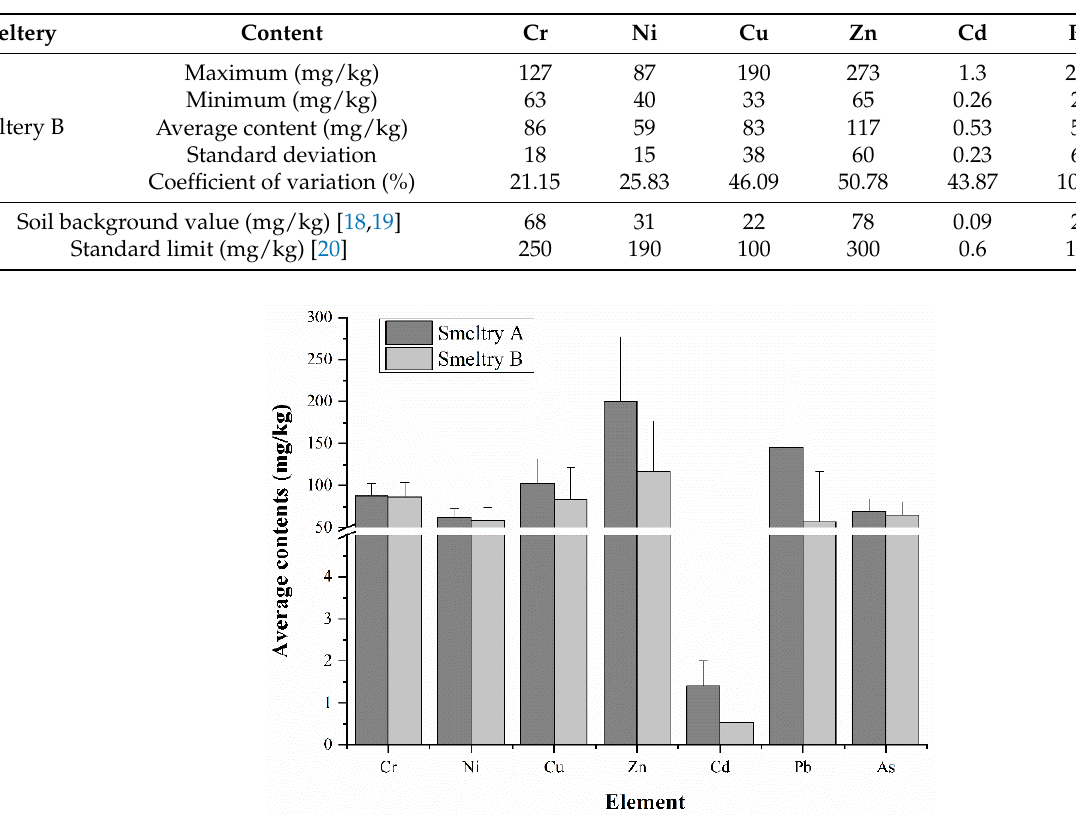
Figure 2. Average contents of heavy metals in soil near two smelters. The average contents of all seven toxic elements around the two smelteries exceeded the local soil background values [18,19]. The detected contents of Cu, Cd, Pb, and As in farmland soil near Smeltery A were 4.68, 15.56, 6.64, and 4.93 times the background content, respectively. The contents of Cu, Cd, and As in the soil near Smeltery B were 3.77, 5.89, and 4.64 times the background content, respectively. Cd was the most serious metal around the two smelteries that exceeded the background value. Pollution by these heavy metals was mainly caused by the large amount of industrial dust produced during the process of heavy metal smelting and soil pollution caused by long-term atmospheric particulate matter deposition [21]. Compared with the risk control standard for the soil contamination of agricultural land promulgated in 2018 [20], Cu, Cd, and As in soil around Smeltery A and As in soil near Smeltery B exceeded the risk screening value of soil pollution on agricultural land. The contents of other elements did not exceed the standard limits. These results indicate that there may be risks when land is used for agriculture, and s afety measures, such as agronomic regulations, should be implemented. The coefficient of variation can be used to reflect the average variation of each sampling point [22]. From Table 2, Pb was the toxic element with the largest coefficient of